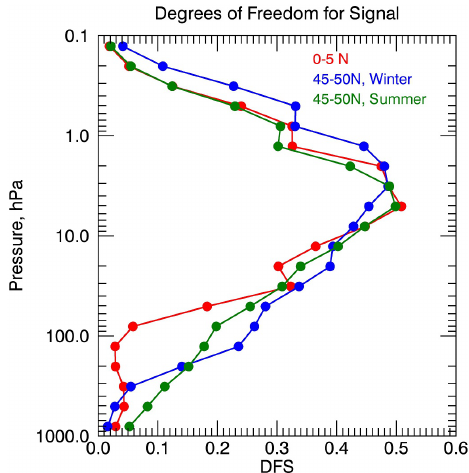
Fig. 3. Typical profiles of layer DFS for the northern midlatitudes in summer (green line), in winter (blue line) and for the tropics (red line). Profiles from NOAA 17, January and July 2007. The connect- ing lines between the data points have no physical meaning and are drawn only to guide the eye.